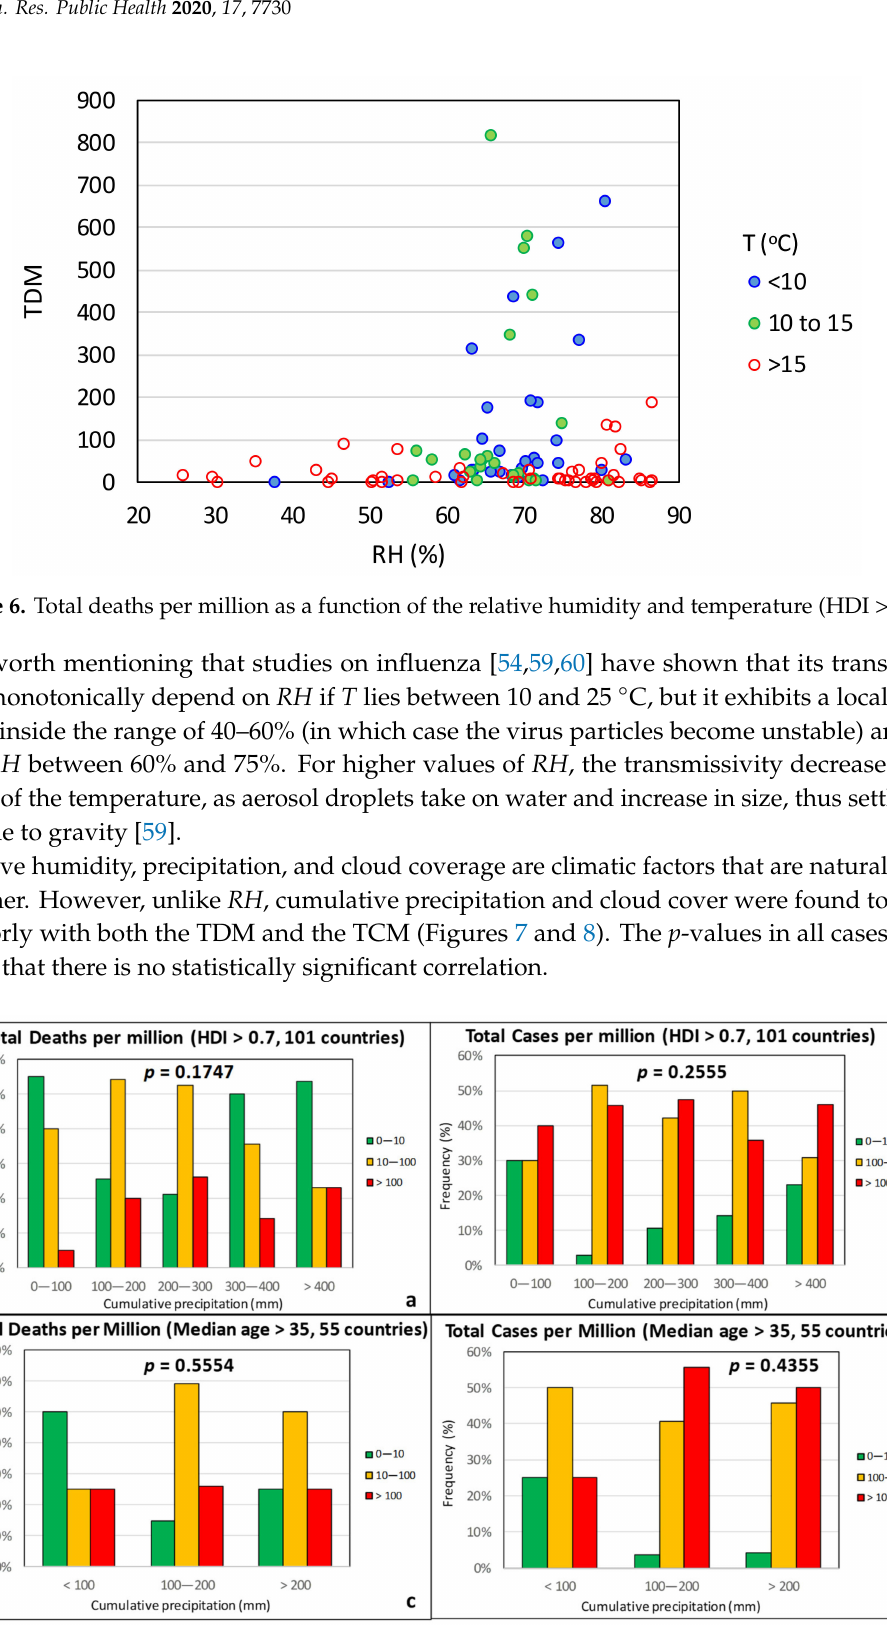
Figure 7. Frequency of total deaths per million (green: low, 0–10; orange: moderate, 10–100; red: high, > 100) and total cases per million (green: low, 0–100; orange: moderate, 100–1000; red: high, > 1000) as a function of the cumulative precipitation for countries with an HDI over 0.7 ( a , b ) and a median age over 35 years ( c , d